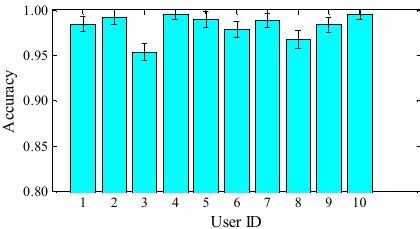
Figure 10. Impact of user diversity.